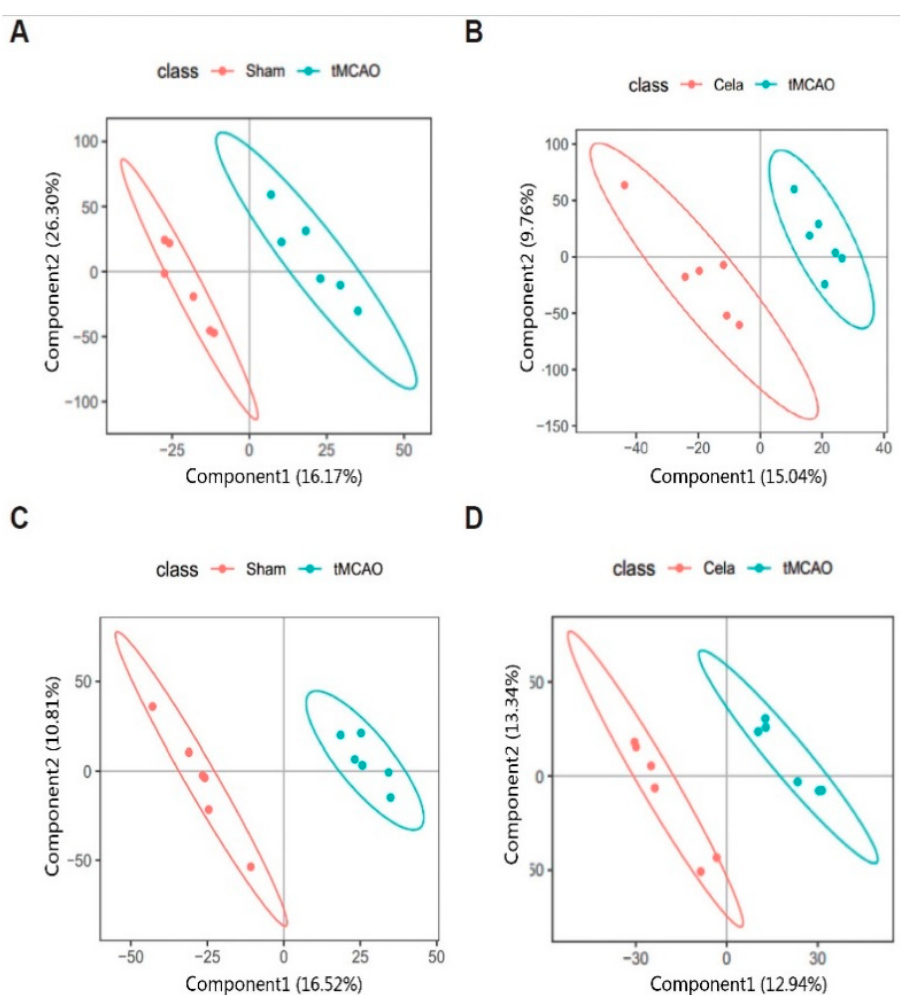
Figure 2. Non-targeted lipidomics analysis of brain and plasma after tMCAO and Cela-treated tMCAO from mice. Plot of brain and plasma PLS-DA between Sham and tMCAO ( A , C ) groups, tMCAO and Cela-treated tMCAO ( B , D ) groups.